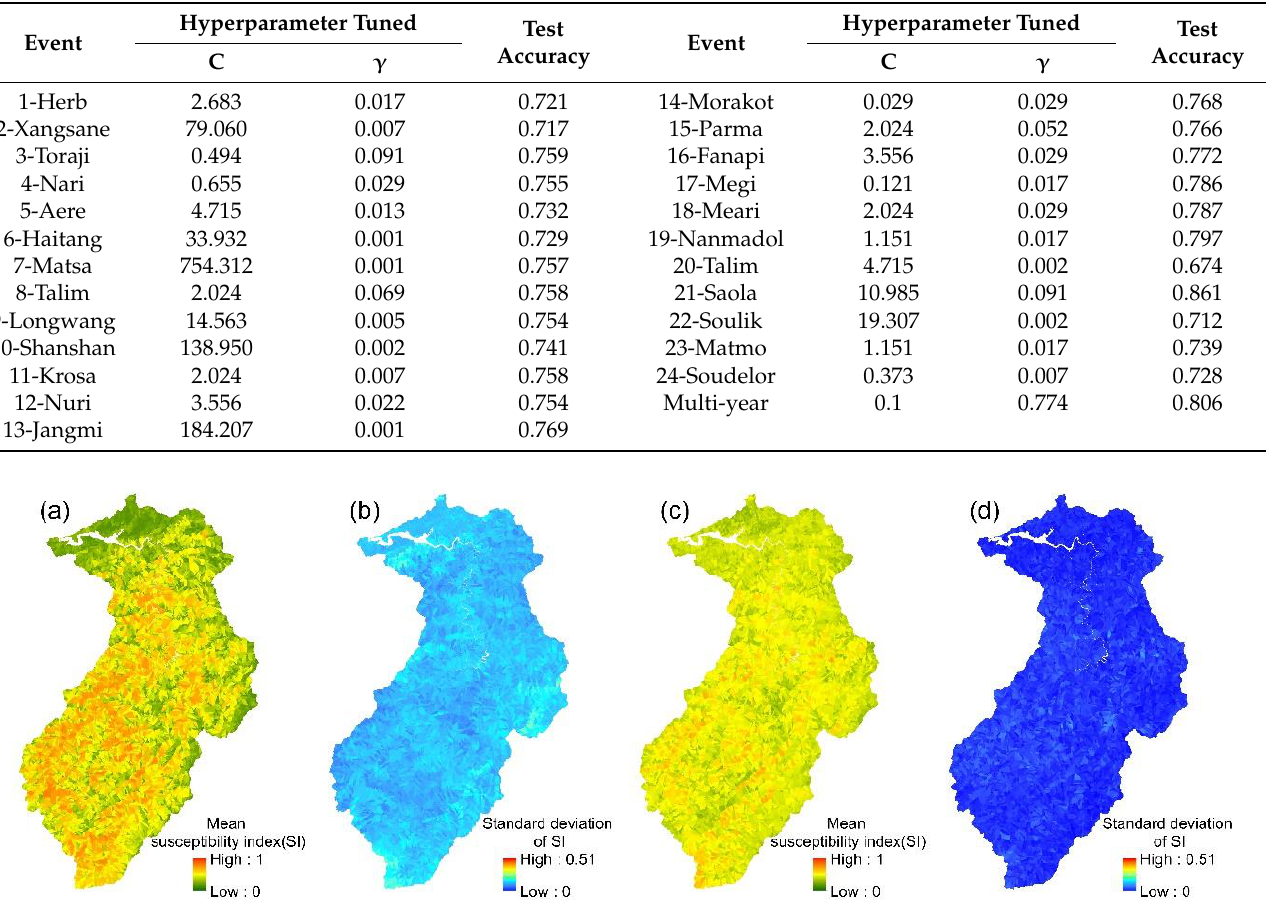
Figure 6. SVM models: ( a , b ) the mean susceptibility index and standard deviation of 24 event-based models; ( c , d ) the mean susceptibility index and standard deviation of the multi-year model.